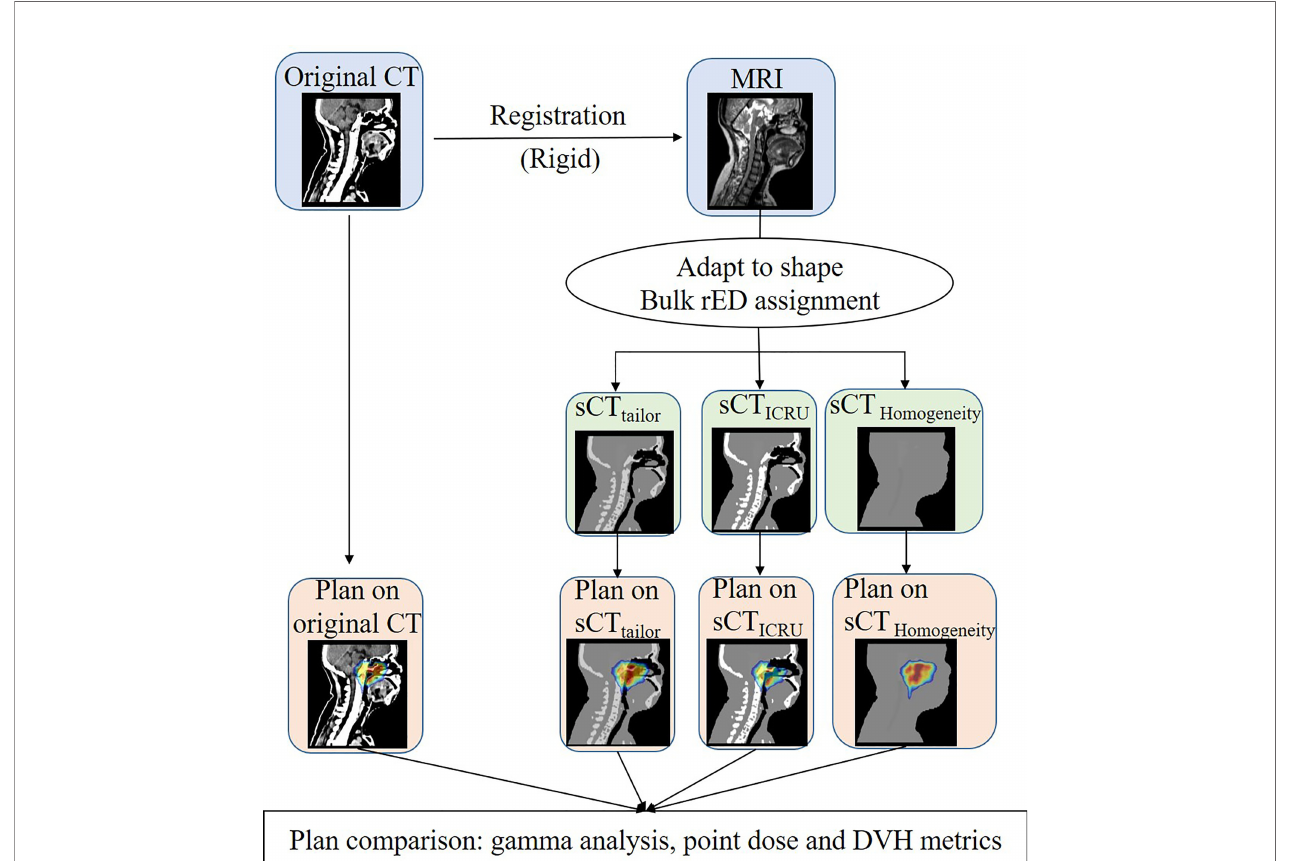
FIGURE 1 | Work fl ow used to generate the three sCT image and to assess the dose calculation accuracy of the bulk approach with respect to sCT ICRU .